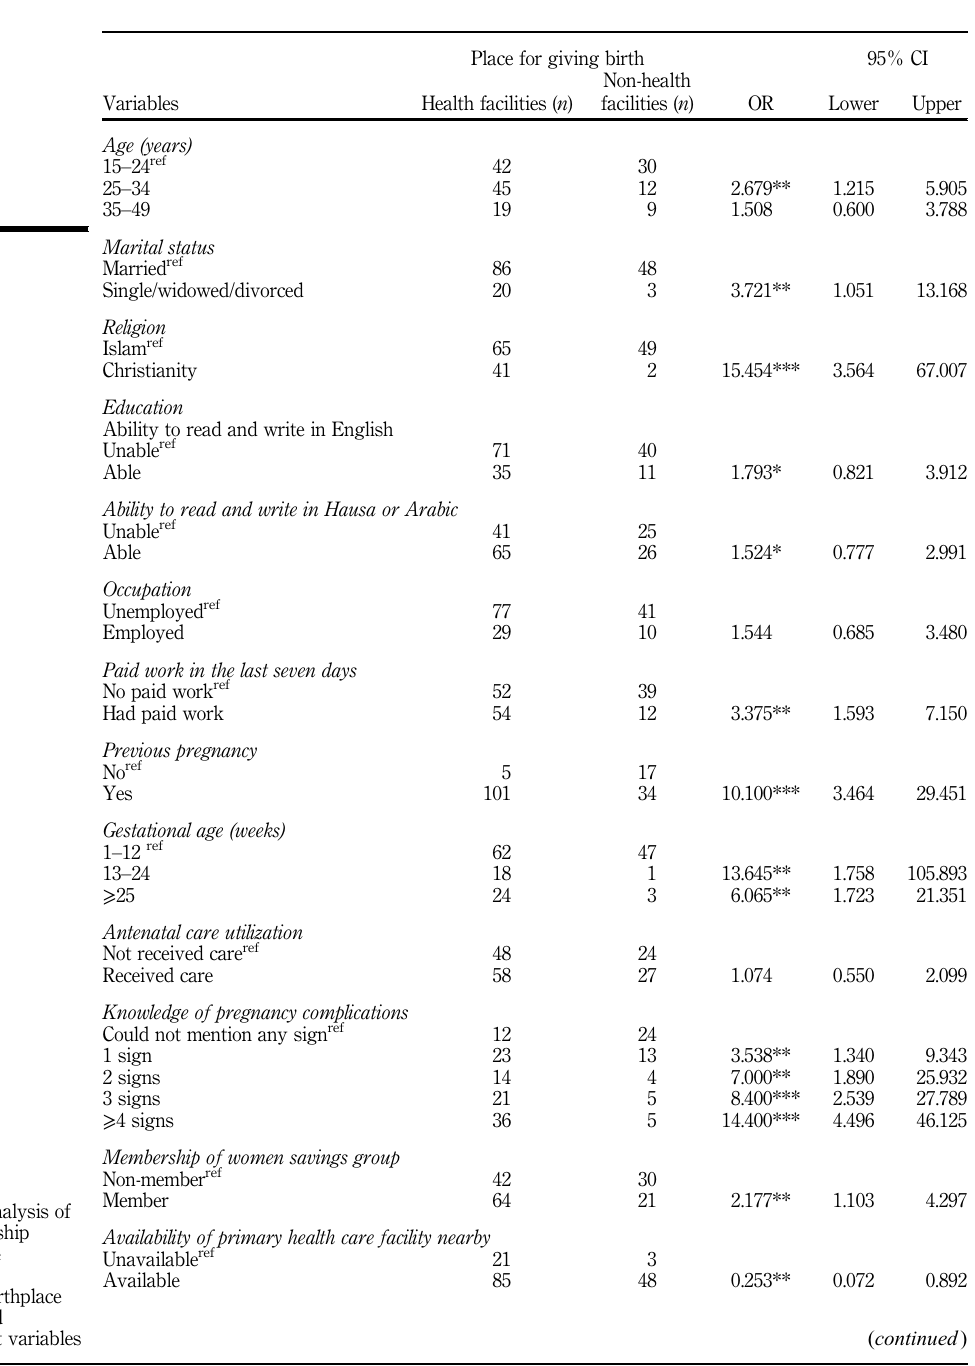
Table II. Bivariate analysis of the relationship between the decision for choosing birthplace and selected independent